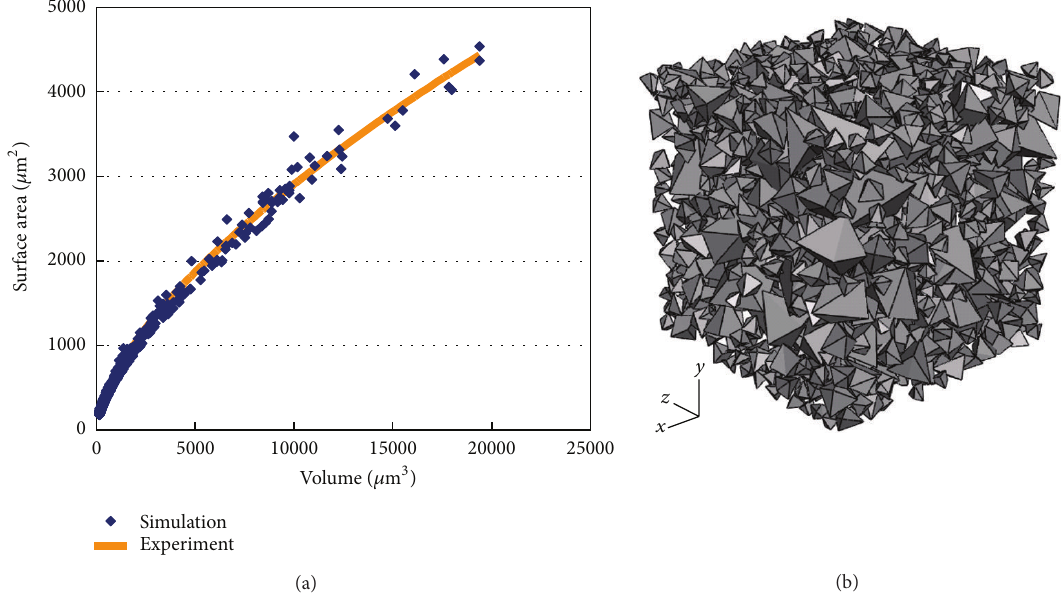
Figure 6: (a) Computer simulation of 1000 particles in the 10 ∼ 50 𝜇 m size range and experimental regression results [7] and (b) visualized structure of compacted grains.